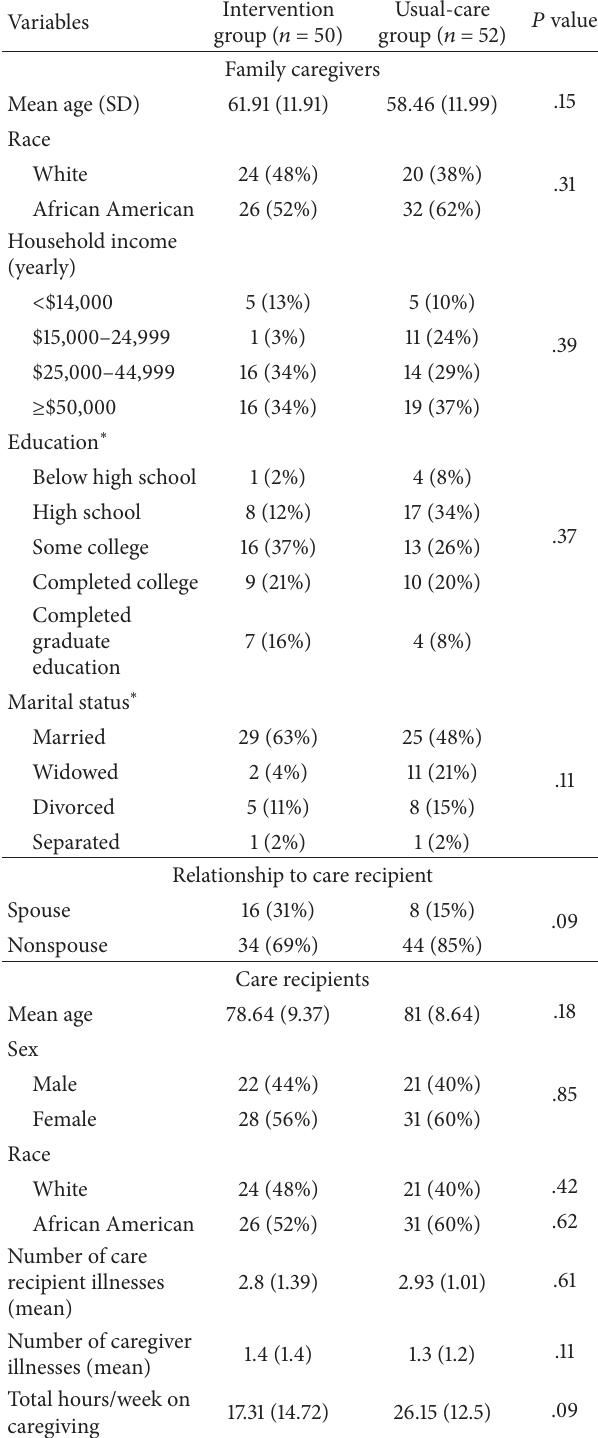
Table 2: Correlations of resourcefulness on outcome measures.